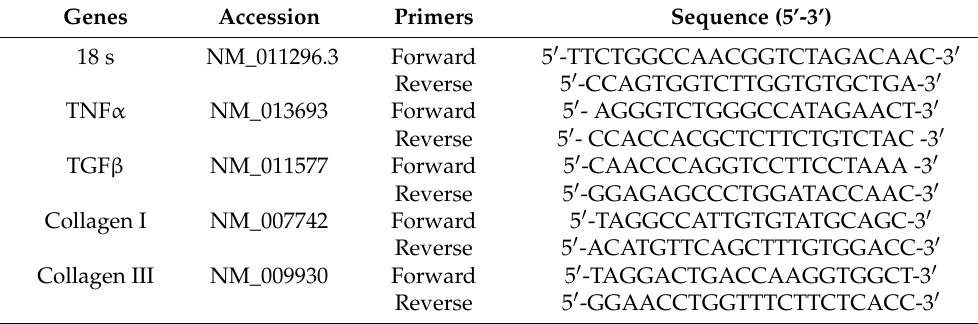
Table 1. The quantitative real-time PCR primer